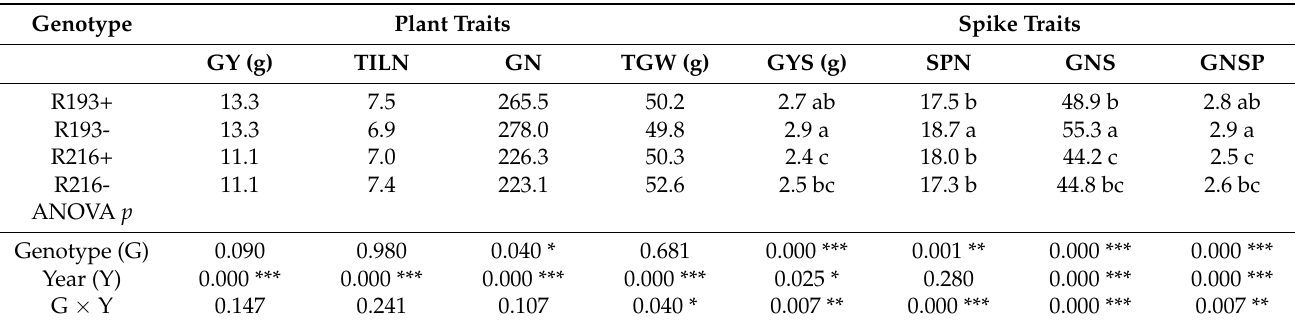
and R216+ vs. R216- comparisons (Table 2). Table 2. Mean values and ANOVA of yield and yield-related traits recorded for 7el 1 L + 7el 2 L recombinants (hom+) and their controls (hom − ) across the 2019 and 2020